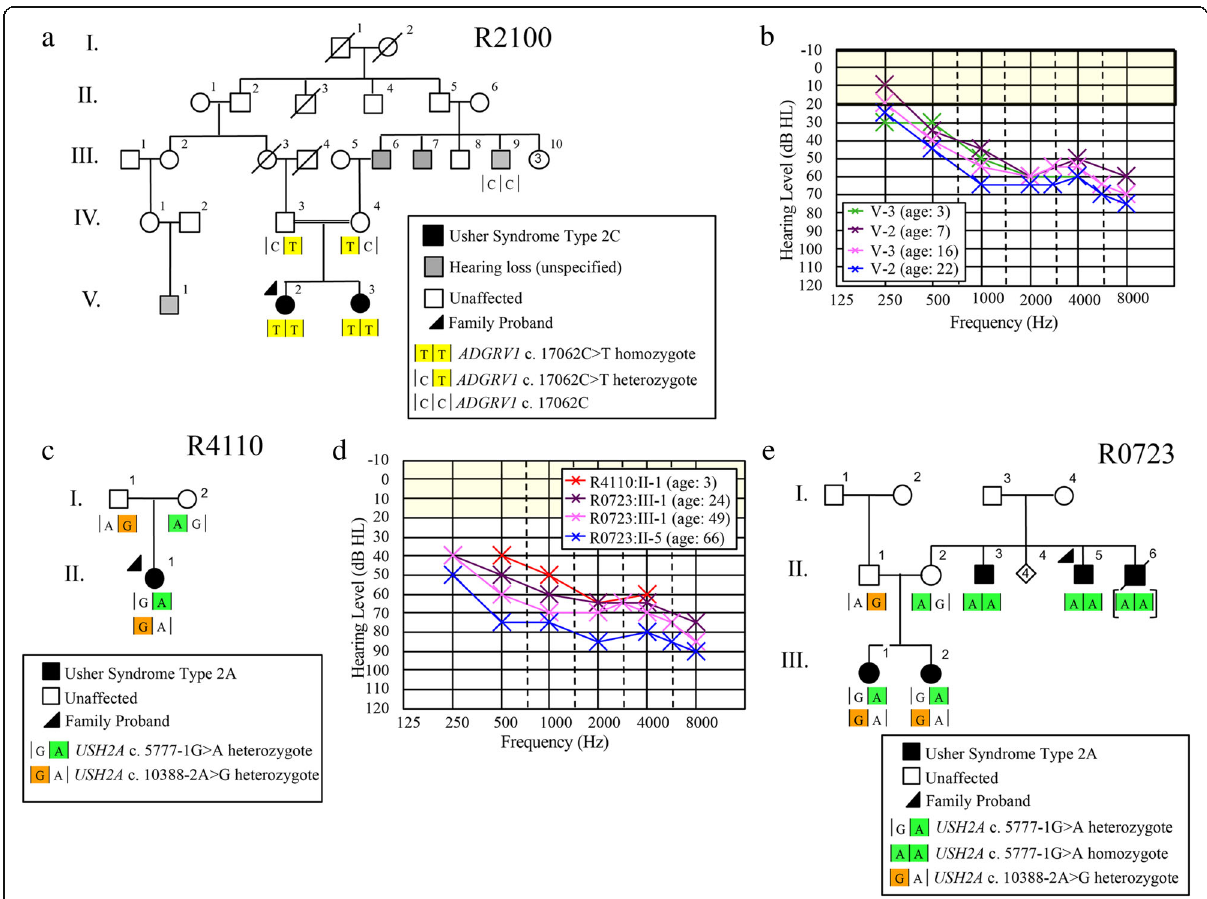
Fig. 1 Pedigrees and audiological data of families that were recruited through either a hereditary hearing loss or eye study, or the medical genetics clinic. a) Family R2100 is a hereditary hearing loss pedigree with multiple affected sibships. Usher syndrome type 2C was not apparent at ascertainment, b) Serial audiograms of PID V-2 and V3 (Family R2100), c) Family R4110 was recruited to this study by our local medical genetics clinic. The proband of this family did not pass newborn hearing screens and was GJB2 -negative, d) Audioprofiles of Usher syndrome type 2A families, e) Family R0723 is an Usher syndrome pedigree with several affected